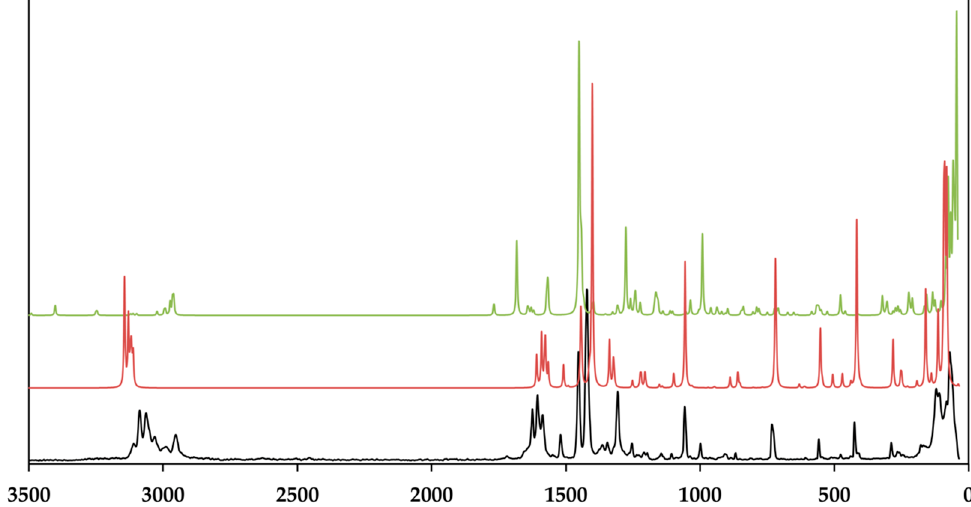
Figure 11. Room temperature raman spectrum of the crystalline [Zn(C 12 H 8 N 2 ) 3 ]C 15 H 13 N 3 O 9 ·5H 2 O (black) and the calculated Raman spectra of the cationic complex (red) and the dianion (green). Theoretical spectra were calculated using BP86/def2-TZVP (cation) and UKS BP86/ma-def2-TZVP (anion), respectively. Raman intensity of the normalized spectra is given in arbitrary units.